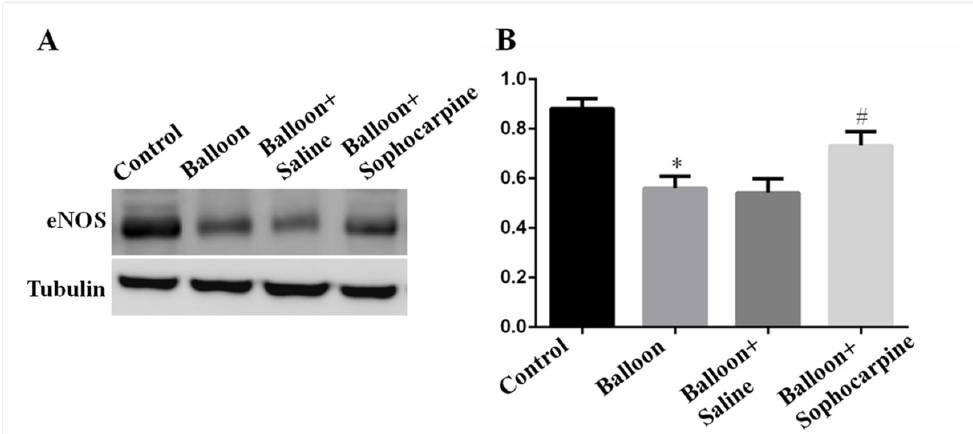
Figure 4. Expression of eNOS in various groups. ( A ) Western blot analysis showed that balloon injury significantly de- creased the expression of eNOS, while sophocarpine induced the expression. ( B ) Quantification of the Western blot re- sults. * p < 0.01 versus the control group, # p < 0.05 versus the balloon group.